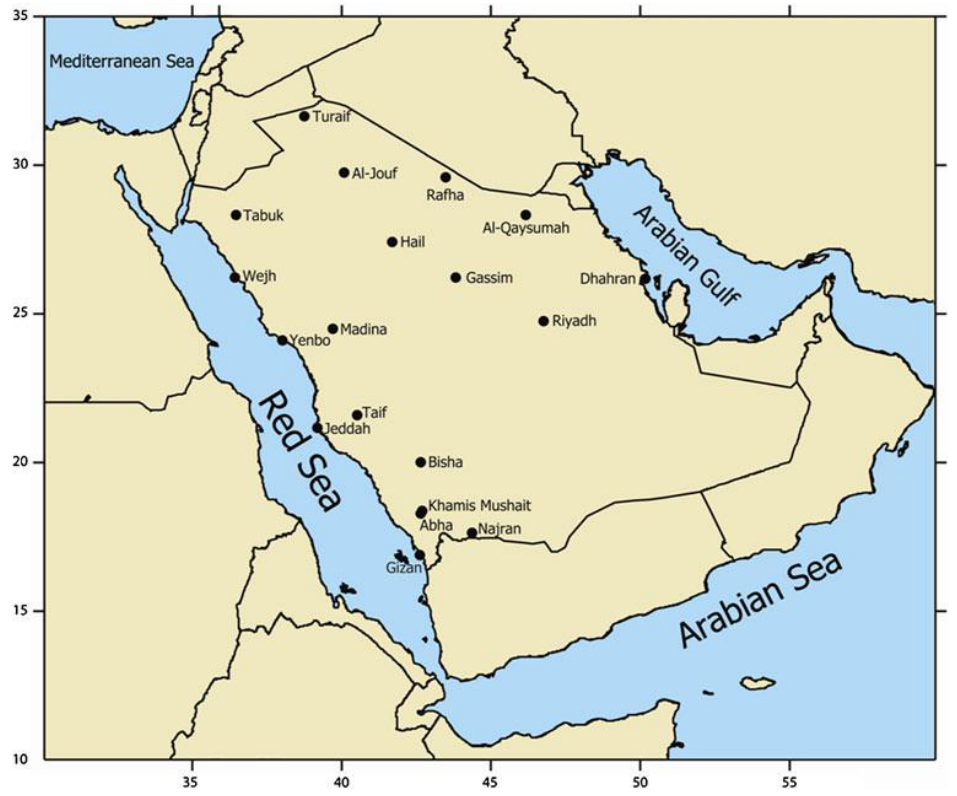
Figure 1. Names and locations of Saudi Arabia stations